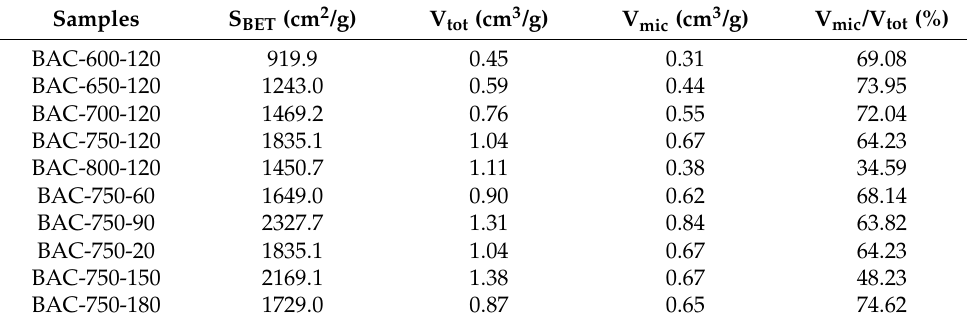
Table 1. Surface areas and porosities of the BACs.